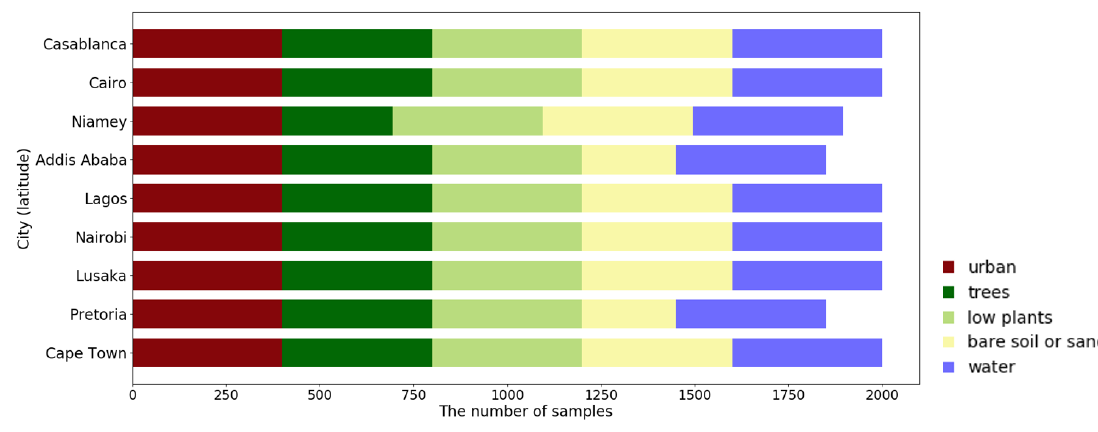
Figure 3. Number and distribution of each land cover class samples in different